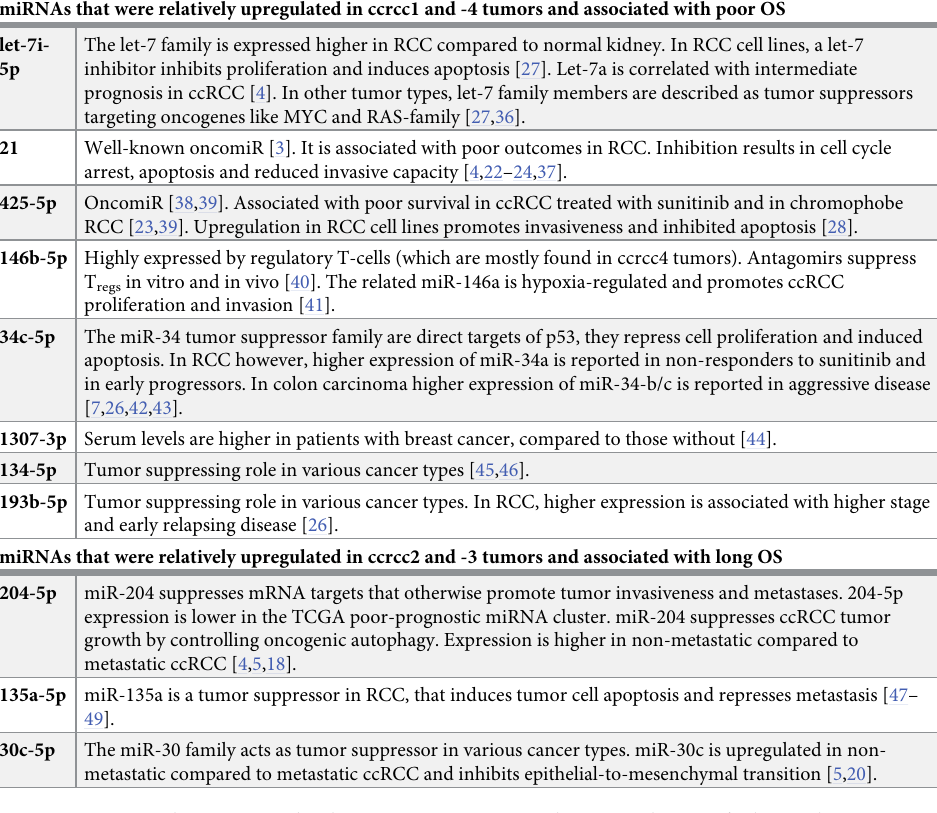
Table 3. Brief literature review of selected miRNAs with the highest discriminatory power for molecular subtype and OS. miRNAs that were relatively upregulated in ccrcc1 and -4 tumors and associated with poor OS let-7i-